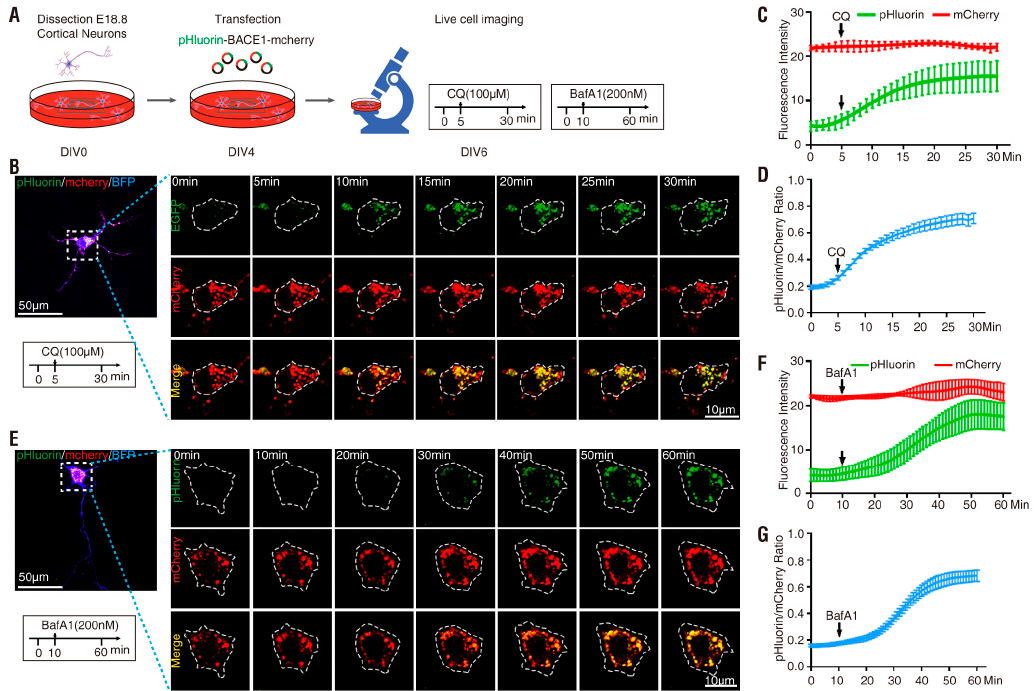
Figure 6. Response of primary cortical neurons expressing pHluorin-BACE1-mCherry to CQ and BafA1 treatment ( A ) Schematics of live cell imaging experimental procedures. Cortical neurons were dissected from E18.5 mice and plated on 35 mm glass-bottom culture dishes at DIV0. Neurons were co-transfected with pHluorin-BACE1-mCherry and BFP at DIV4 and imaged every minute for 30 min at DIV6 and treated with 100 µM CQ after 5 min or imaged every minute for 60 min at DIV6 and treated with 200 nM BafA1 after 10 min. ( B ) Representative images from live cell imaging in response to CQ. The soma expressing pHluorin-BACE1-mCherry (red and green) were outlined according to BFP expression. Scale bar, 10 µm or 50 µm. ( C ) The fluorescence signal intensity of mCherry (red) and pHluorin (green) in the outlined area was measured using ImageJ and plotted over time in response to CQ. Data were shown as mean ± SEM ( n > 15 neurons from three independent experiments). ( D ) Quantification analysis of the pHluorin / mCherry ratio from C. Data was shown as mean ± SEM ( n > 15 neurons from three independent experiments). ( E ) Representative images from live cell imaging in response to BafA1. The soma expressing pHluorin-BACE1-mCherry (red and green) were outlined according to BFP expression. Scale bar, 10 µm or 50 µm. ( F ) The fluorescence signal intensity of mCherry (red) and pHluorin (green) in the outlined area was measured and plotted over time in response to BafA1. Data were shown as mean ± SEM ( n > 15 neurons from three independent experiments). ( G ) Quantification analysis of the pHluorin / mCherry ratio from F. Data was shown as mean ± SEM ( n > 15 neurons from three independent